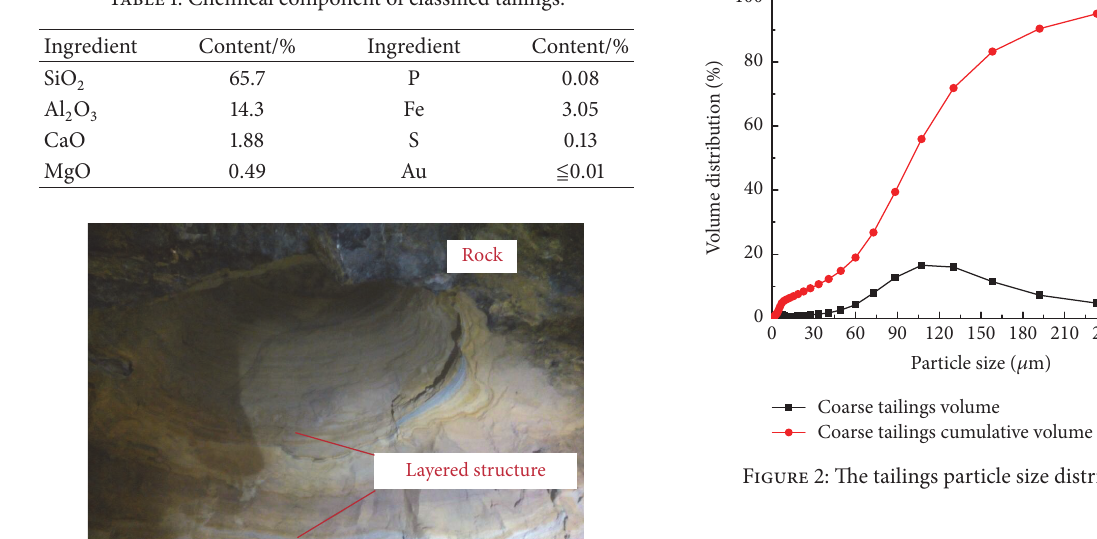
Table 1: Chemical component of classified tailings.